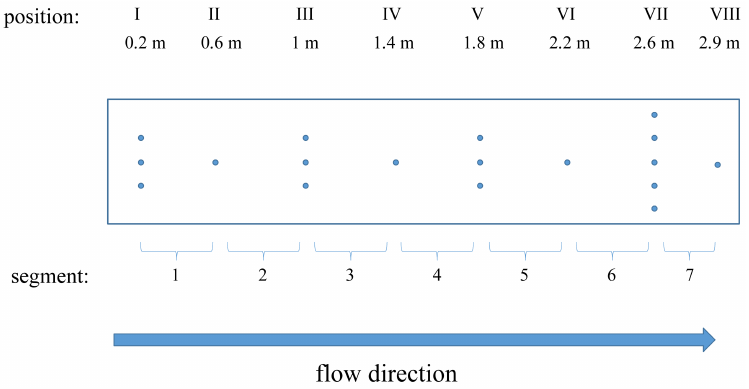
Figure 6. Positionof the pressure measuring holes in the channel (Roman numbers) and segments, where the pressure difference was determined (Arabic